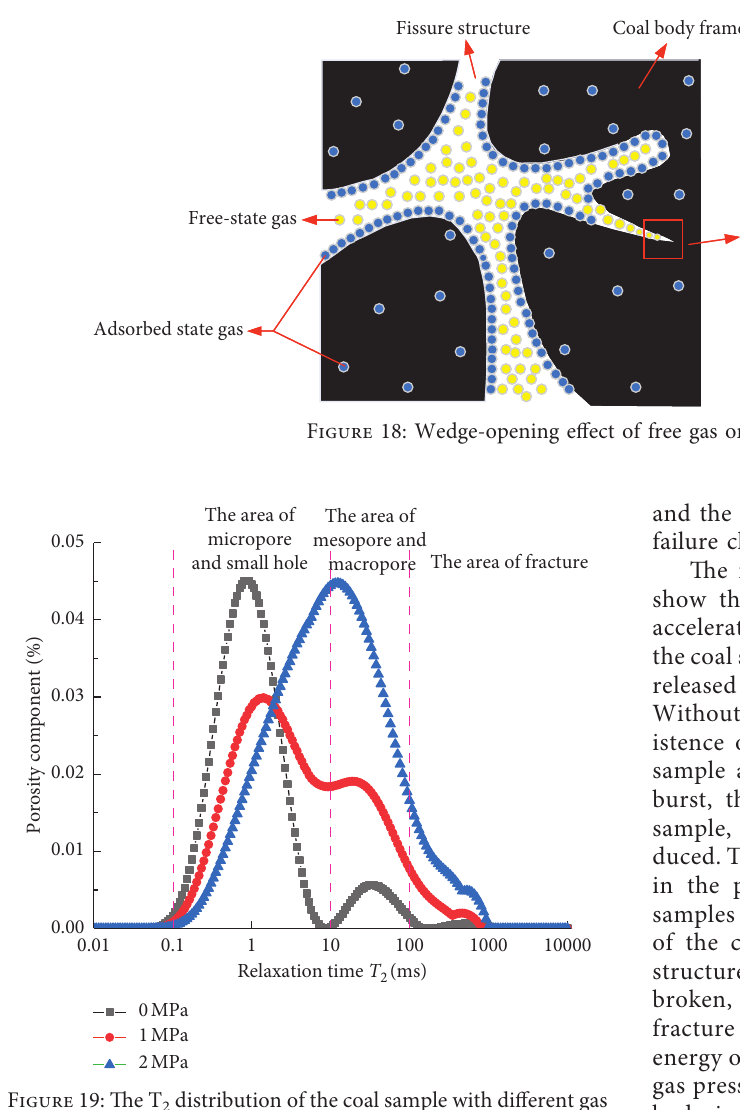
2 distribution of the coal sample with different gas